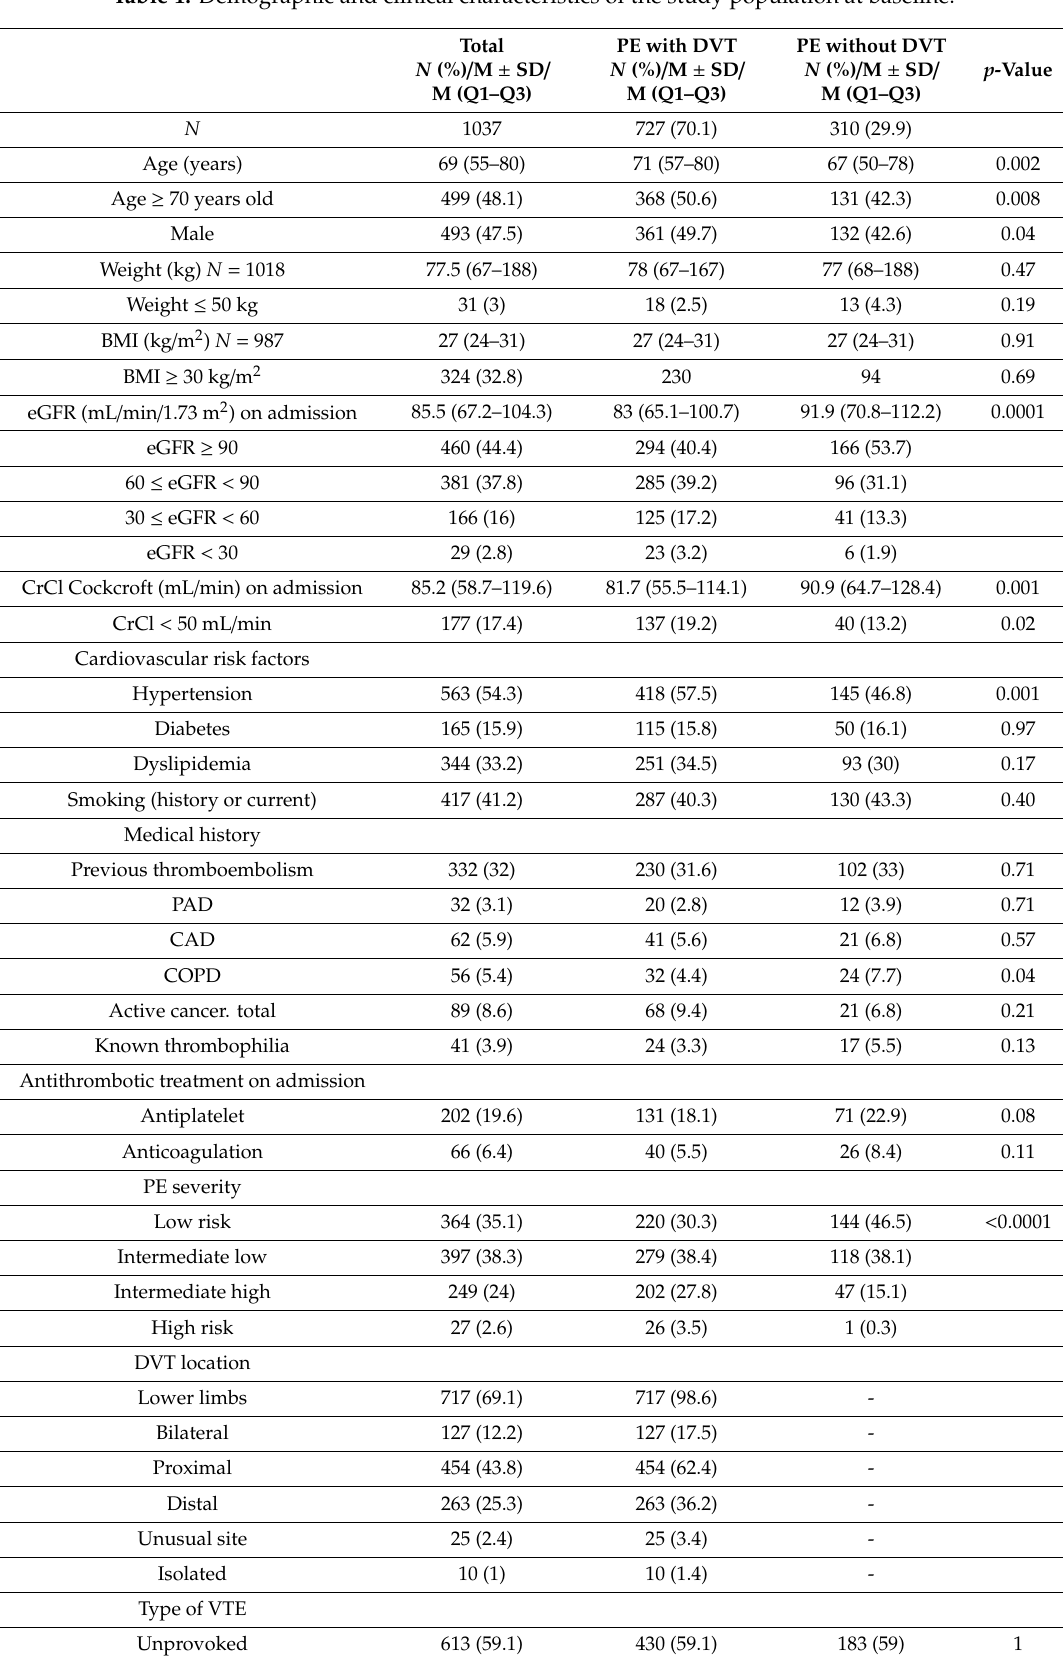
Table 1. Demographic and clinical characteristics of the study population at